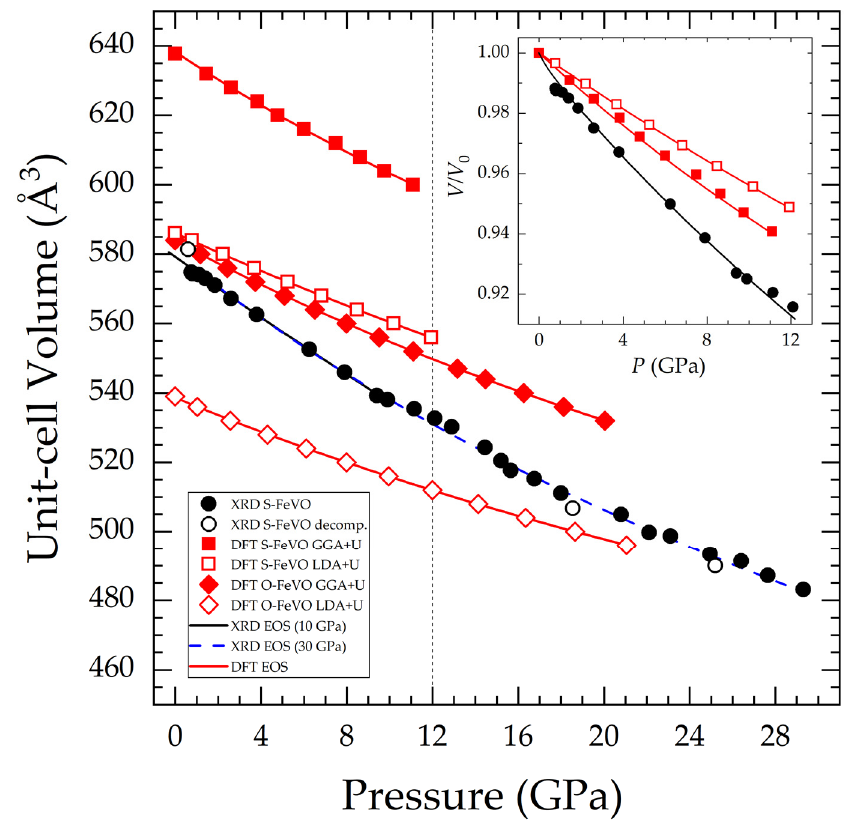
Figure 5. FeV 2 O 4 unit-cell volume as a function of pressure. Black filled circles correspond to experimental S-FeVO on compression and open circles to S-FeVO on decompression data. Red squares represent DFT S-FeVO (filled for GGA+U and empty for LDA+U). Red diamonds represent DFT O-FeVO (with the displayed volume doubled in order to correspond to the same number of formula units). Lines correspond to third order Birch-Murnaghan EOS. Two EOS are fitted to the experimental S-FeVO data, one up to 10 GPa and one up to the maximum pressure. The vertical dashed line at 12 GPa corresponds to the critical pressure for the onset of pressure-induced chemical decomposition. The normalized volume for S-FeVO data is shown in the inset.